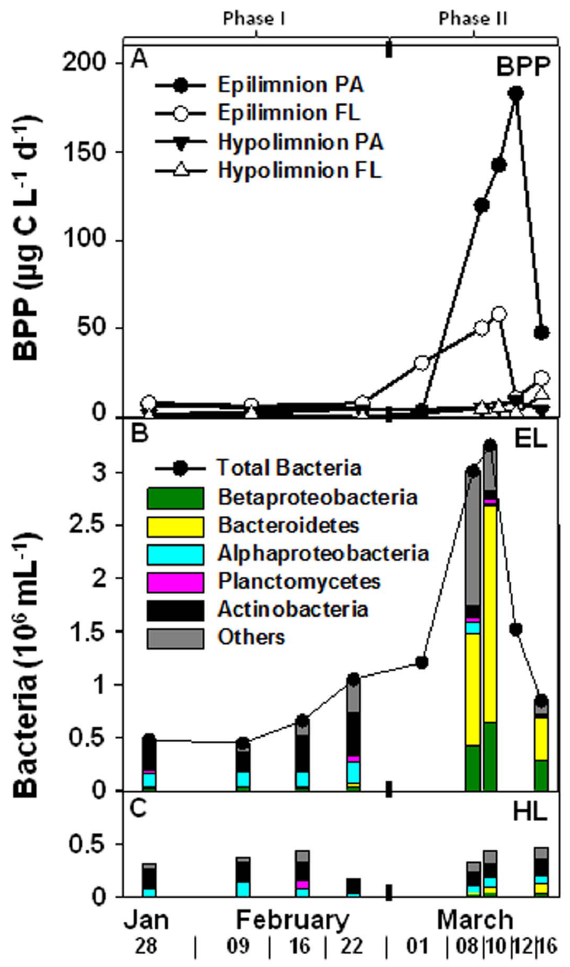
Figure 3. Bacterial protein production (BPP) of particle-attached (PA) and free-living (FL) bacteria in the epilimnion and hypolimnion (A) and bacterial abundance of total bacteria in the epilimnion (B) and hypolimnion (C) during the two phases of the